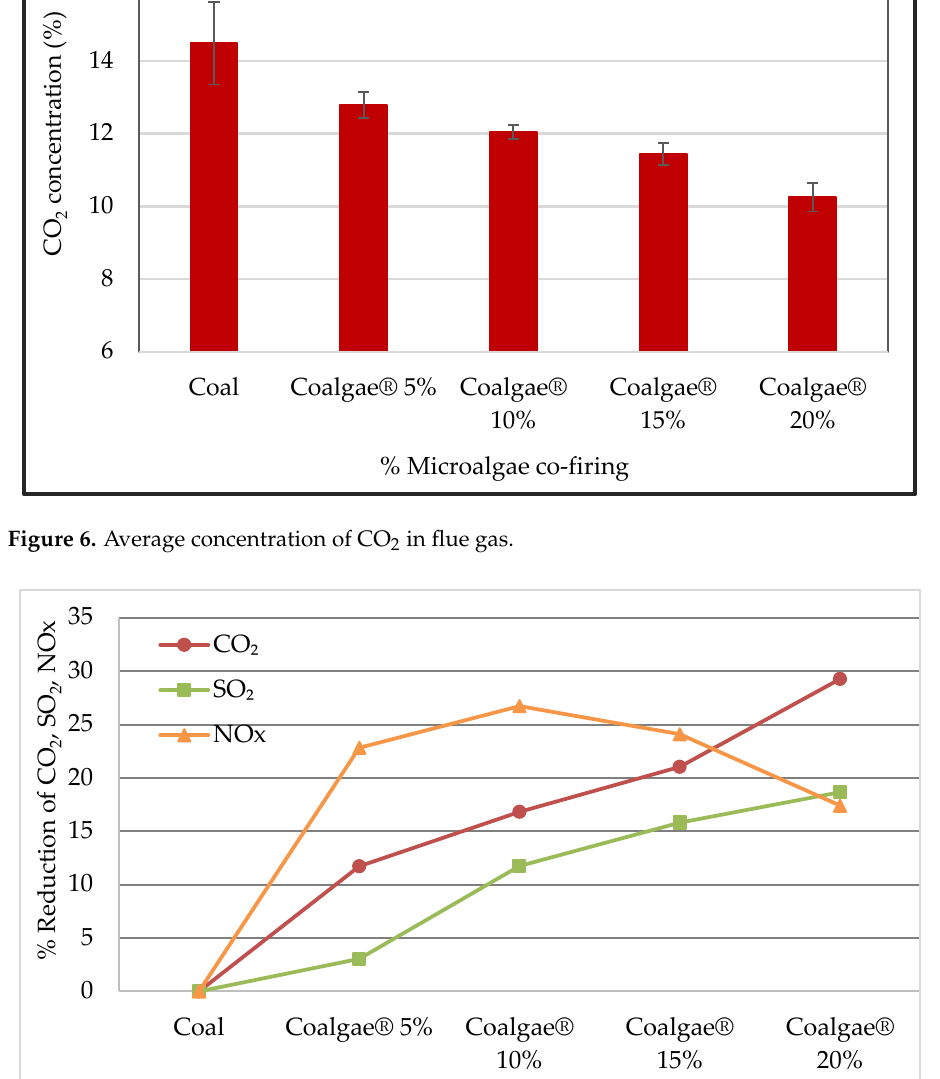
Figure 7. Effect of microalgae co-firing on CO 2 , SO 2 and NOx reduction.